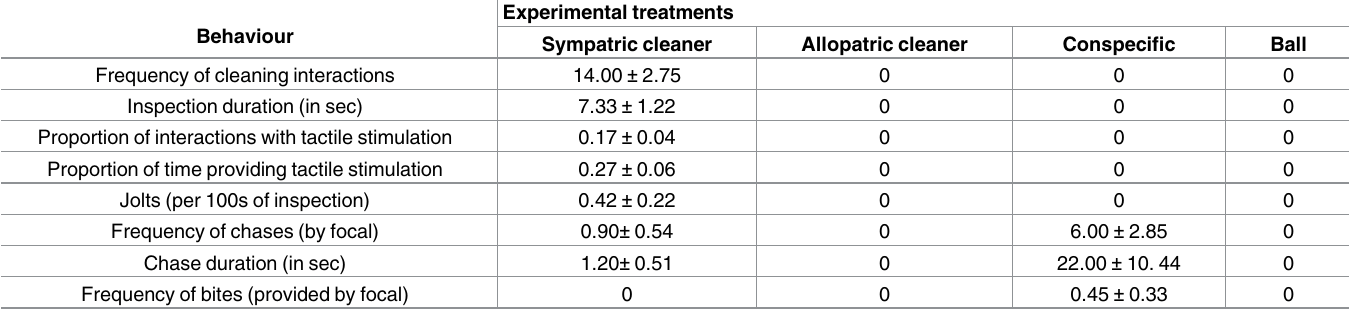
Table 1. Frequency of observed behavioural measuresfor each experimental treatment. These include: a) the frequency of cleaninginteractions,b) mean inspectionduration, c) proportionof interactions in which tactile stimulationwas appliedto clients, d) frequency of jolts per 100 s of inspection, e) fre- quency of chases, f) durationof chases and g) frequencyof bites given by focal individual. Mean ± StandardError (SEM) are provided for each behavioural